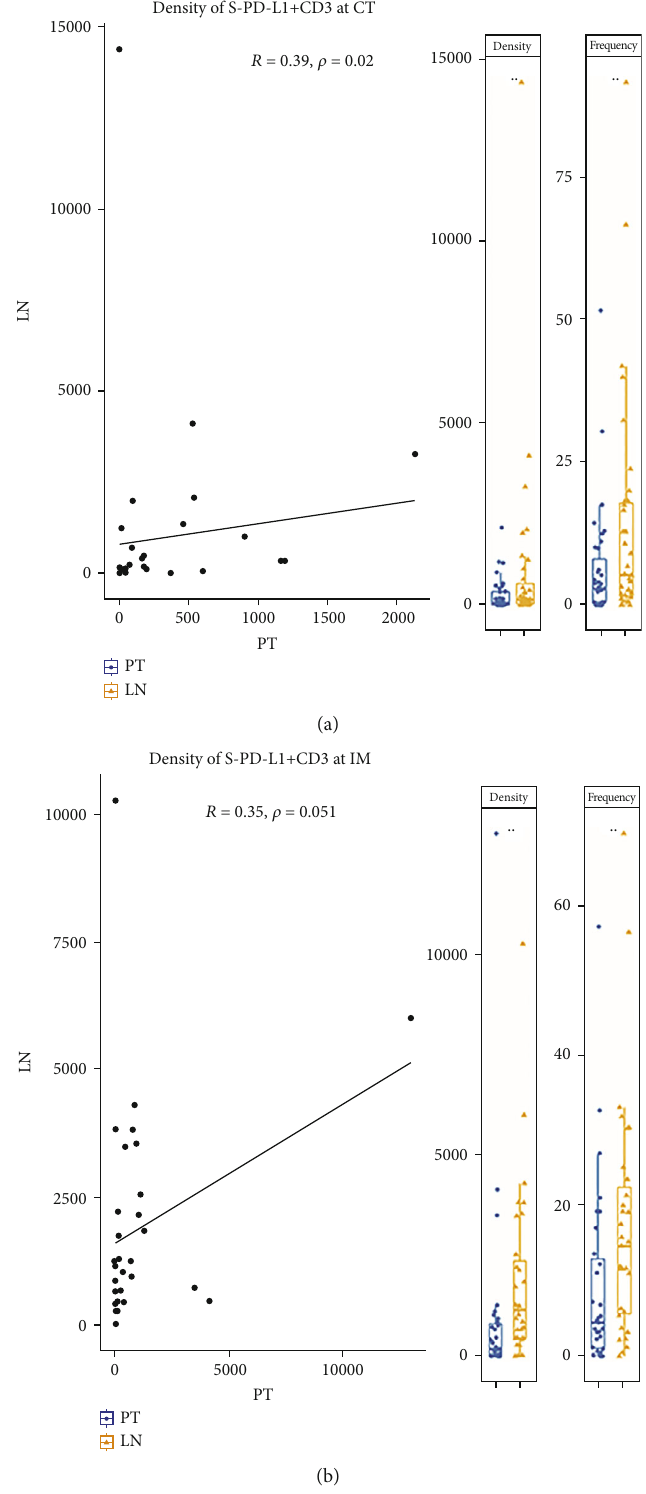
Figure 3: The densities of stromal PD-L1-positive T cells (S-PD-L1+CD3+) in the center of tumor (CT) region (a) were signi fi cantly correlated between primary tumor (PT) and metastatic lymph node (mLN); (b) in contrast, a marginally signi fi cant correlation was found in the invasive margin (IM) region. The densities and frequencies of S-PD-L1+CD3+ were signi fi cantly higher in mLNs than in PTs irrespective of location. CT=center of tumor; IM =invasive margin; S =stroma ∗ P < 0 : 05 ; ∗∗ P < 0 : 01